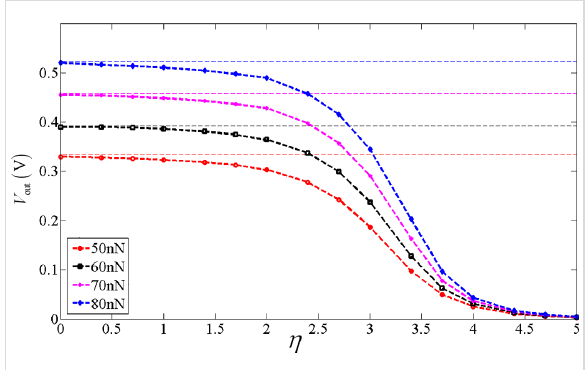
band. Hence, the output voltage becomes very low. This phe- nomenon indicates again that a smaller initial carrier concentra- tion is more proper for energy harvesting with a bent ZNW [31].